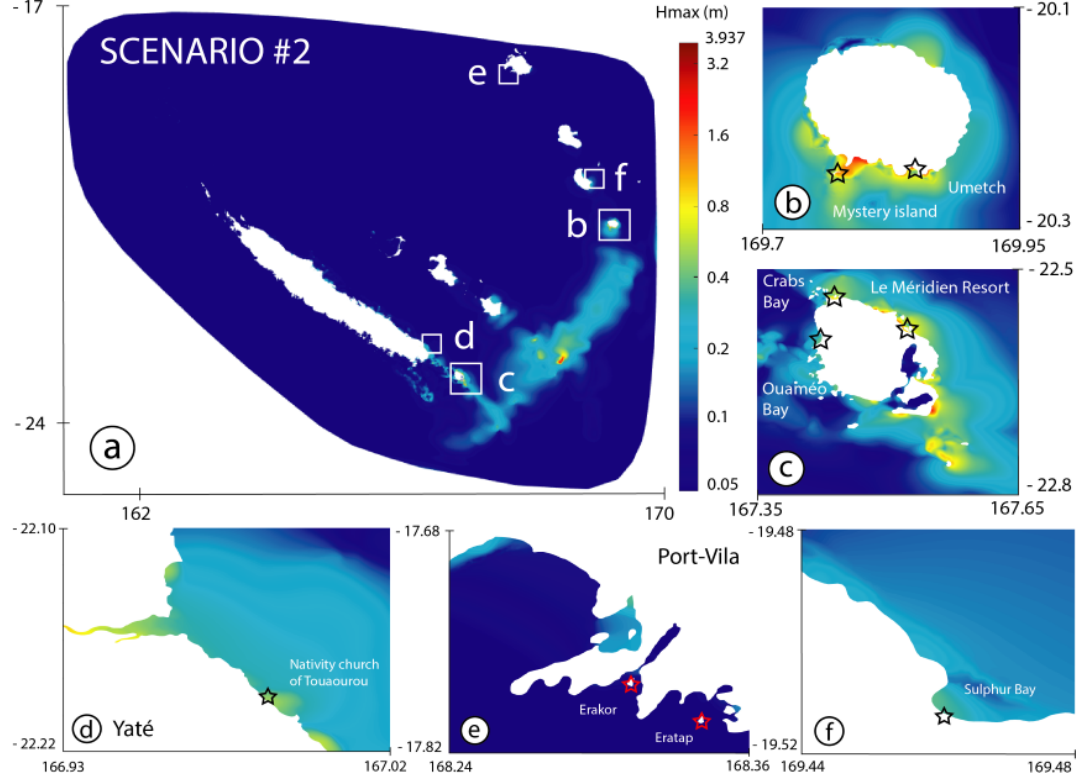
Figure 8. Maximum wave amplitude maps ( H max ) obtained after 3h of tsunami propagation on the TIN DEM for scenario 2 (UM) in New Caledonia and South Vanuatu. (a) Across the entire area; (b) the island of Aneityum; (c) the Isle of Pines; (d) Yaté; (e) Port Vila, Efate; (f) Sulphur Bay, Tanna. Stars stand for eyewitnesses’ observation points.